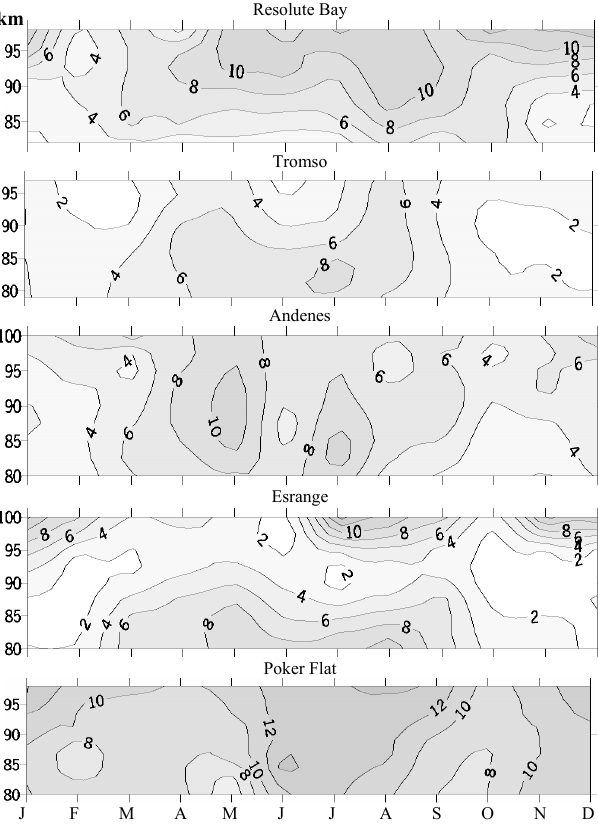
Fig. 12. As Fig. 11, but for monthly mean amplitudes of DT, merid- ional